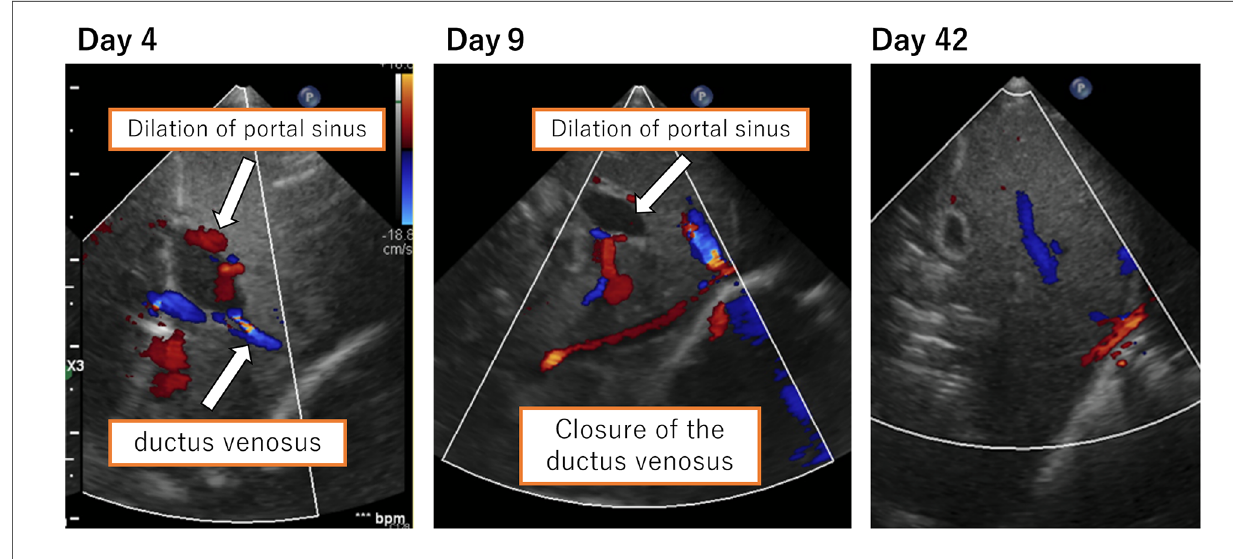
FIGURE 2 Ductus venosus and dilation of the portal sinus. Closure of the ductus venosus was con fi rmed on the 9th day of life. Dilation of the portal vein resolved on the 42nd day of